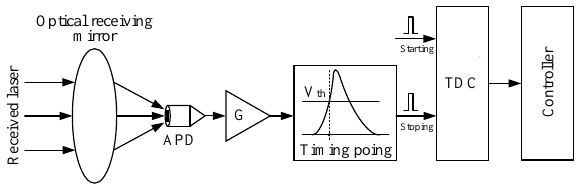
Figure 1. The framework of the receiving